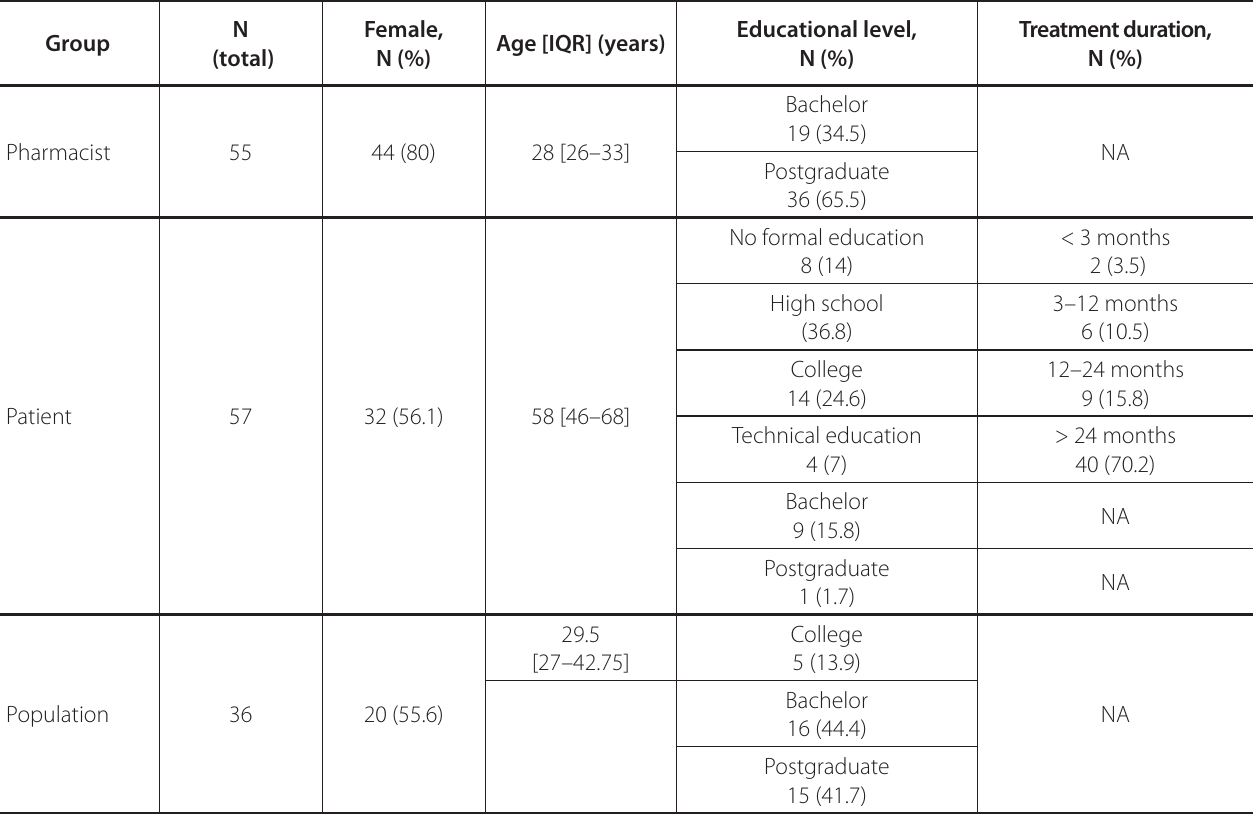
Table 1 . Demographic characteristics of the sample.